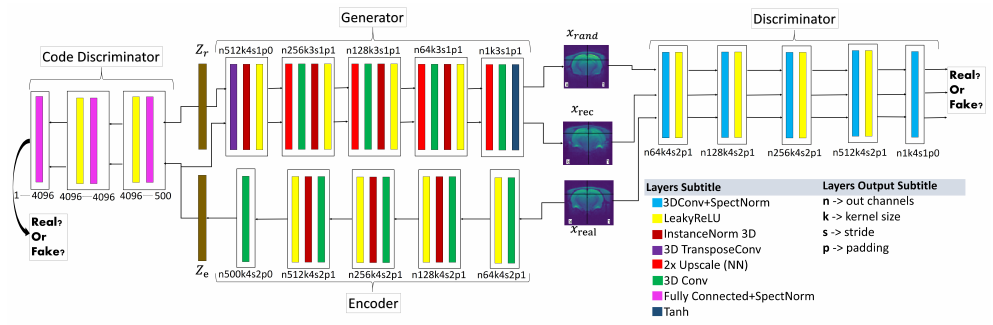
Figure 6. α -WGANSigmaRat2 architecture. Near each layer is displayed a code that explains the result of each convolution, e.g., n256k3s1p1: n256, size of the output channels (in this case 256); k3, kernel size (cubic dimension 3 × 3 × 3); s1, stride (1 × 1 × 1); p1, padding (1 × 1 × 1). Please use the virtual version to get a more detailed